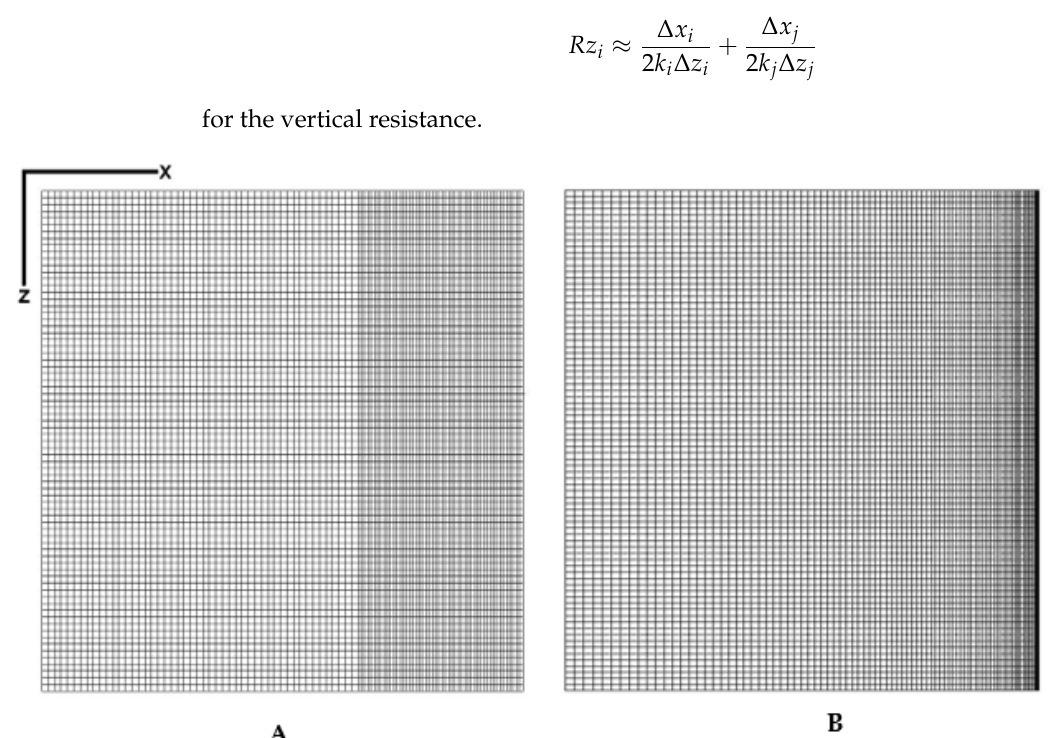
Figure 2. ( A ) Abrupt change. ( B ) Gradual change in the x direction.